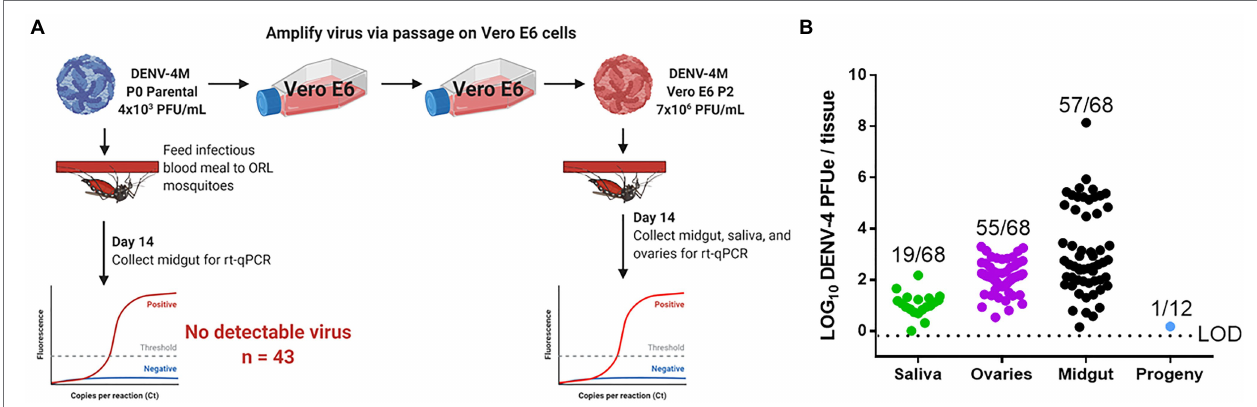
FIGURE 4 | Detection of DENV-4M genome by rt-qPCR after per os infection in 14 dpi Orlando (ORL) mosquito tissues. (A) Workflow of in vivo infection. Parental P0 DENV-4M stock yielded no infection in 43 tested 14 dpi midguts. Virus was passaged 2x in Vero E6 cells and ORL mosquitoes were infected with this product. (B) Rt-qPCR was performed on saliva, ovaries, and midguts dissected from each of 68 individual mosquitoes. Log 10 DENV-4 PFU equivalents (PFUe)/tissue, as determined by converting cycle threshold (CT) values with a standard curve made using 10-fold dilutions of RNA extracted from virus stock with a known PFU/ml of 7 × 10 6 are reported. The values reported represent the mean of two technical rt-qPCR replicates. The LOD of the assay was a CT value of 40 or 0.65 PFUe/tissue. The three biological replicates reported were performed in separate tissue culture flasks processed in parallel. Only samples with a detectable CT value in both technical replicates are shown on the graph; the proportion of rt-qPCR positive samples / total samples tested is displayed over each tissue type. Results are pooled from three independent experiments (saliva, ovaries, and midgut) or two independent experiments (adult female